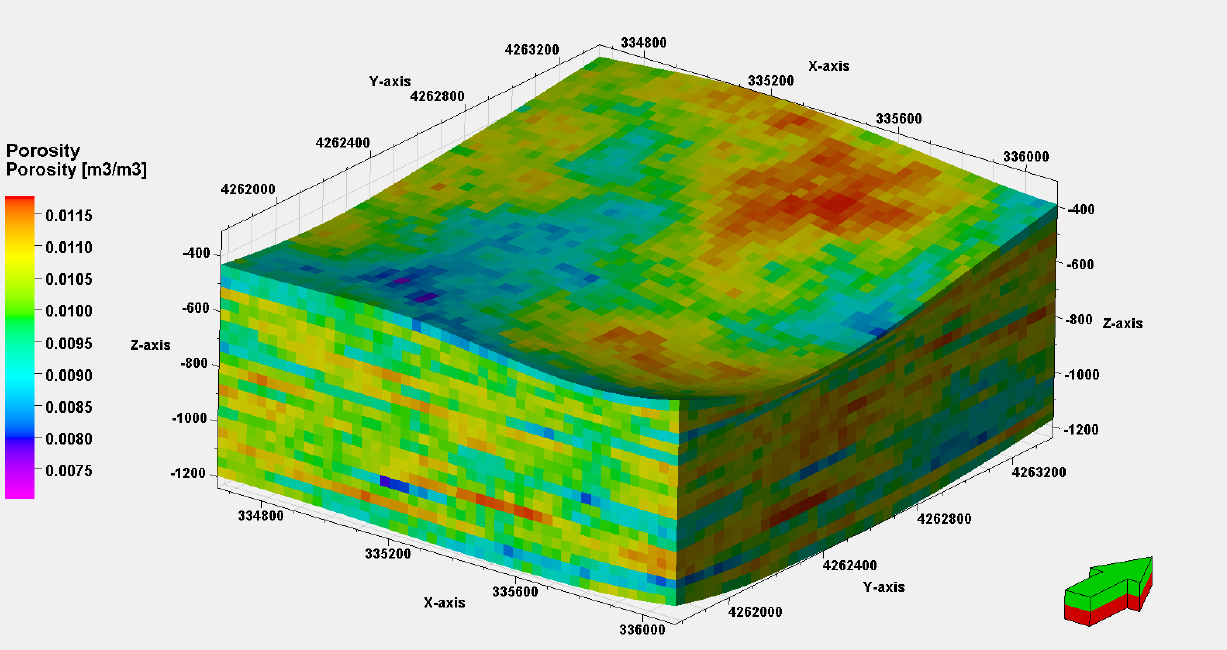
Figure 6. Porosity distribution in the model’s grid